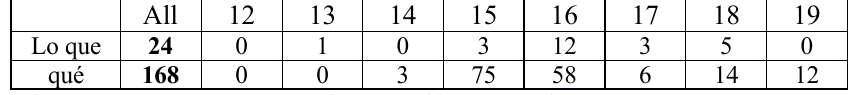
Table 10: Saber lo que + subj. /saber qué + subj. All Lo